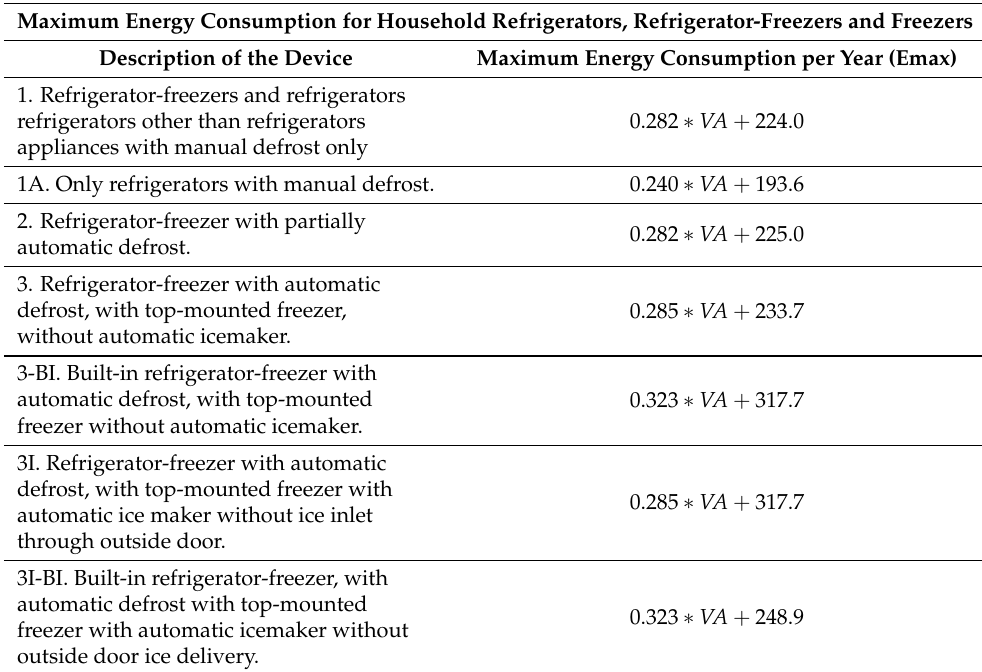
Table 4. Energy Consumption Estimation for Different Refrigeration Devices in Mexico, adapted from [72].